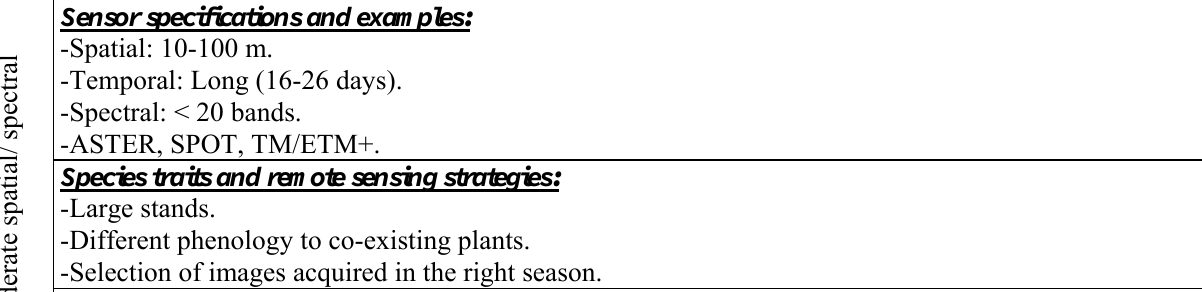
Table 1. Summary of remote sensing applications for non-native plant